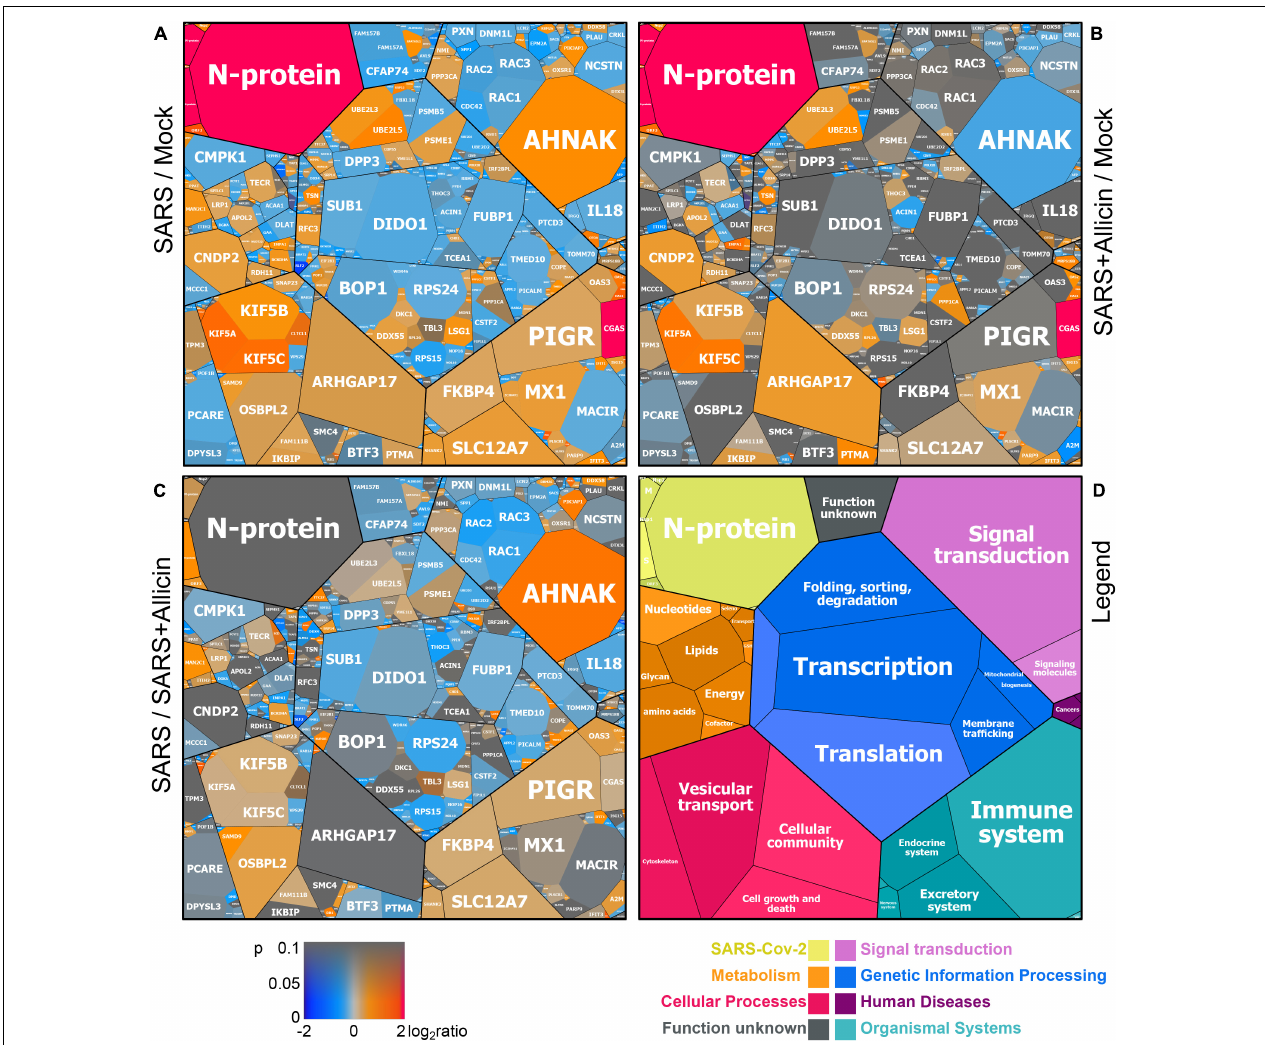
FIGURE 5 | The effect of allicin on the proteome of SARS-CoV-2 infected Calu-3 cells. The host-viral proteome treemaps (A–C) show the 536 differentially expressed proteins upon SARS-CoV-2 infection and were constructed by the Paver software (Mehlan et al., 2013). The treemaps visualize the following proteome changes: (A) SARS-CoV-2 infection/Mock, (B) SARS-CoV-2 infection + Allicin/Mock and (C) SARS-CoV-2 infection − /+ Allicin. The treemap (D) serves as legend for the functional KEGG categories displayed in different colors for level 1 and sublevel 2 as listed in Supplementary Table 3 . The cell sizes in panels (A–C) denote the average abundances of 207 proteins with ≥ 1.5-fold inductions and 329 proteins with < 0.66-fold decreased expression after SARS-CoV-2 infection. The log2 ratios of the proteins are shown by a red-blue color gradient (red – induction, blue – repression) (A–C) . p -values ( p < 0.05; p < 0.01) were calculated using an unpaired two-tailed t -test from 3 to 4 biological replicates with 1–3 technical replicates ( Supplementary Table 3